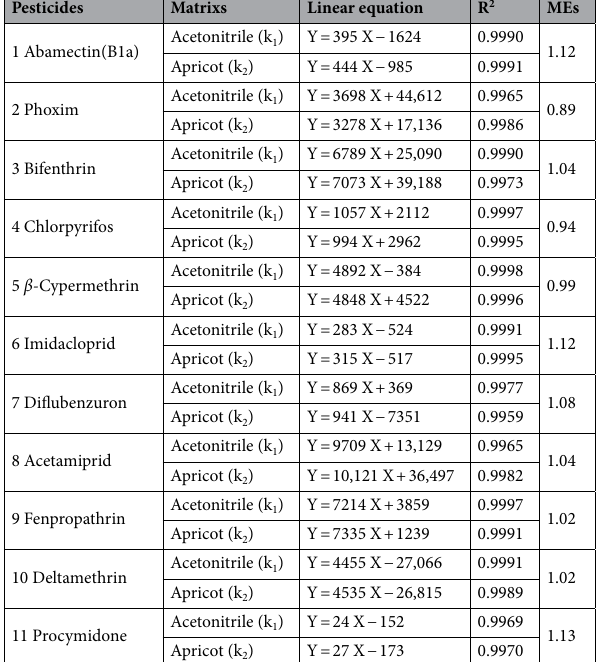
Table 1. The standard curves, R 2 and MEs of 11 pesticides in apricot.